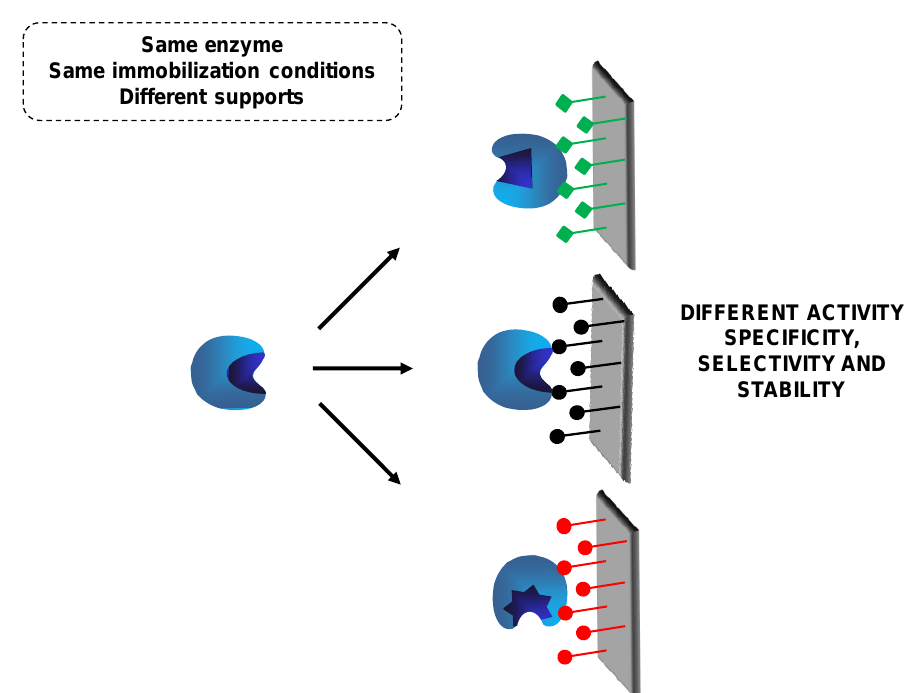
Figure 17. Effect of the immobilization support on the conformation of the immobilized enzyme. Tuning lipase activity, selectivity, specificity and stability.